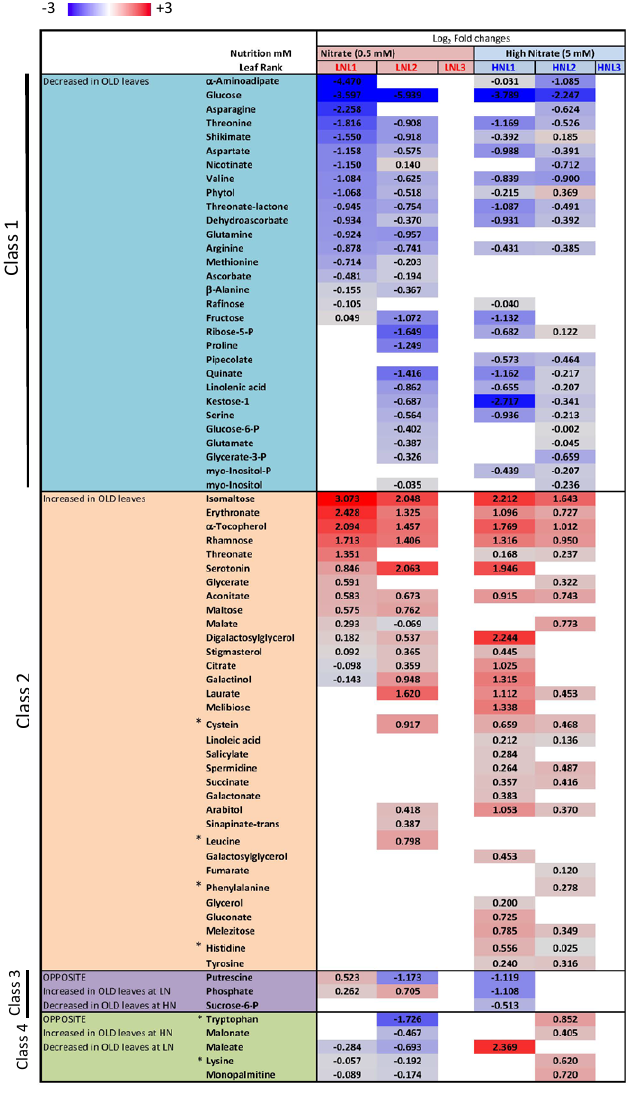
Figure 2. Metabolite changes during primary leaf senescence of plants grown under low (LN) or high nitrate (HN) conditions. Values for each metabolite were first measured as peak area in GC-MS analyses normalized according to the ribitol internal standard and to the mg FW (see Supplementary Data Set 1). ANOVA and Newman-Keuls (SNK) comparisons were performed in order to select the metabolites whose relative contents significantly changed with leaf senescence. Only these significantly different metabolites are presented in the figure. The Log 2 Fold changes from L3 were then calculated independently for LN and HN leaves on the mean of eight biological repeats. The values range from low (blue) to high (red) metabolite-relative content compared to the youngest leaf (L3). The scale bar of red and blue shades ranges from − 3 to +3. Class 1 represents metabolites decreased during leaf senescence, Class 2 metabolites accumulated during senescence, Class 3 metabolites accumulated in LN leaves and decreased in HN leaves during leaf senescence and Class 4 metabolites decreased in LN leaves and increased in HN leaves during leaf senescence. Asterisks identify amino